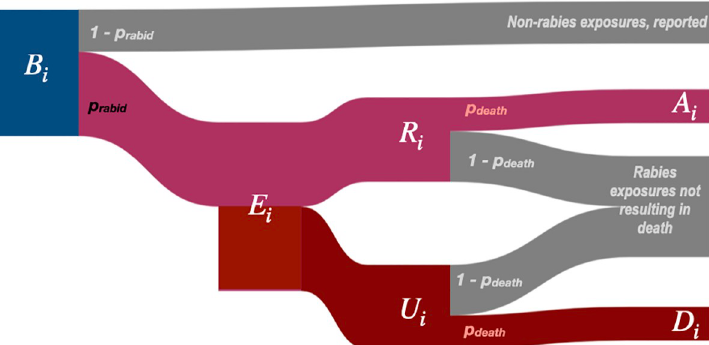
Fig 1. Decision tree for burden estimation. For a given administrative unit i, human deaths due to rabies (D i ) are calculated from model predicted reported bites (B i ). To get R i , the number of reported bites that were rabies exposures, we multiply B i by p rabid , the proportion of reported bites that are rabies exposures. R i is subtracted from E i to get the number of unreported bites (U i ) and then multiplied by the probability of death given a rabies exposure (p death ) to get deaths due to rabies (D i ). Similarly, deaths averted by PEP, A i , are estimated by multiplying R i by p death , i.e. those who would have died given exposure, but instead received PEP. Both E i and p rabid are drawn from a triangular distribution. Parameter values and sources are listed in Table